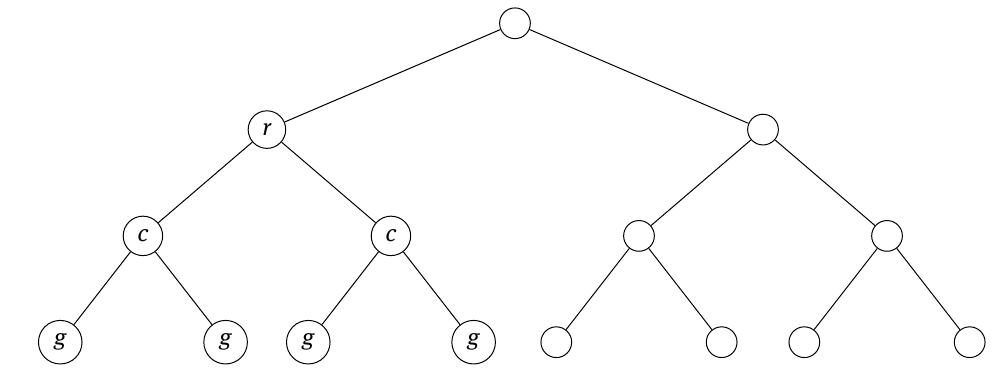
Fig. 2. Tree T 3 with a subtree labelled with letters. The root of the subtree is labelled with r , its children - with c , and its grand- children - with g